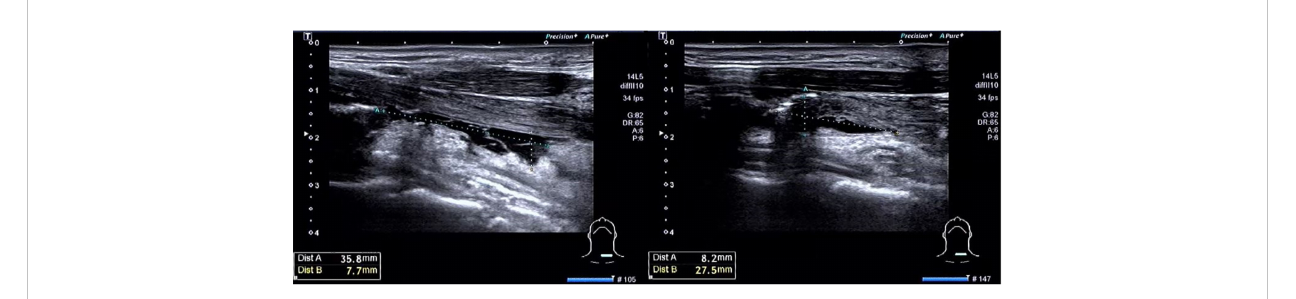
FIGURE 2 Measurement of cervical effusion by ultrasound.